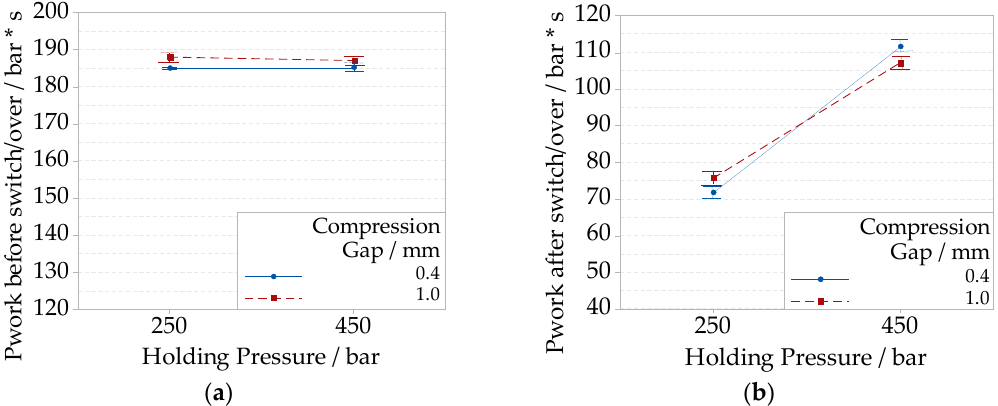
Figure 12. Interaction plots of the integral of pressure over time for the different compression gap and holding pressure levels: ( a ) calculated on a time interval that goes from zero to end of filling (before switch/over); ( b ) calculated on a time interval that goes from the end of injection until end of compression (after switch/over).